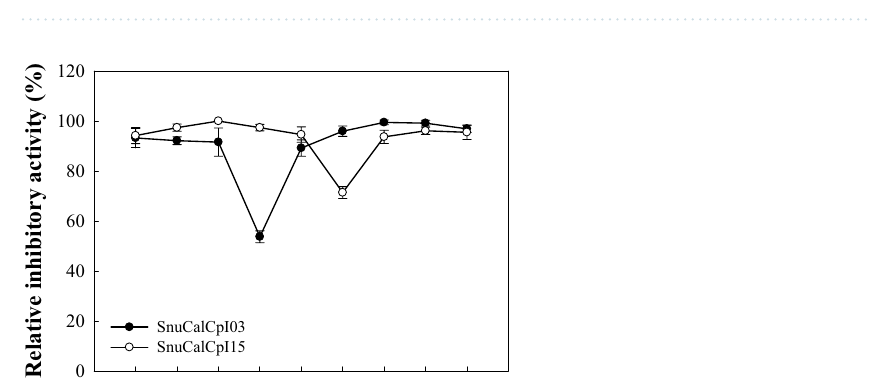
Figure 4. Thermal stability of SnuCalCpI03 ( ● ) and SnuCalCpI15 ( ○ ).